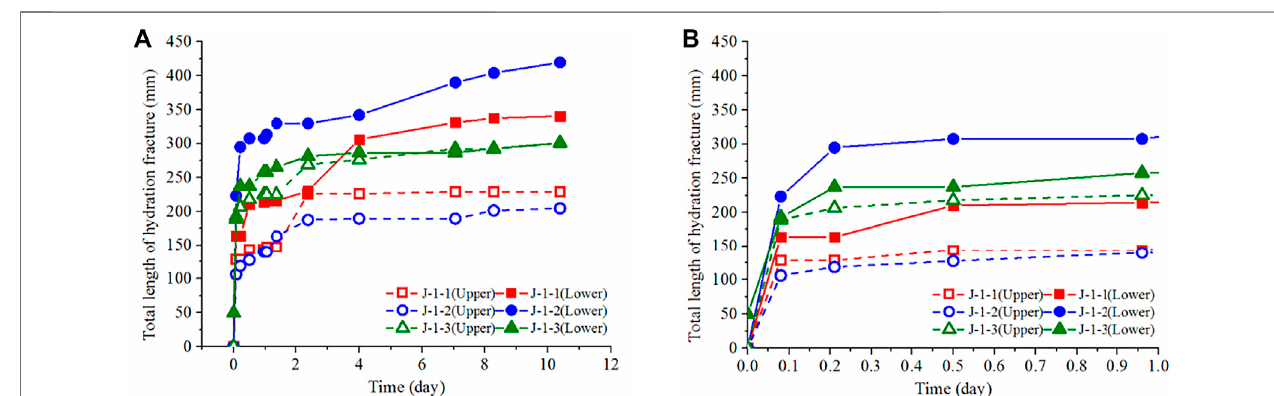
FIGURE 6 | Increase of the length of hydration fractures soaking in distilled water with time: (A) complete period, and (B) the fi rst day.